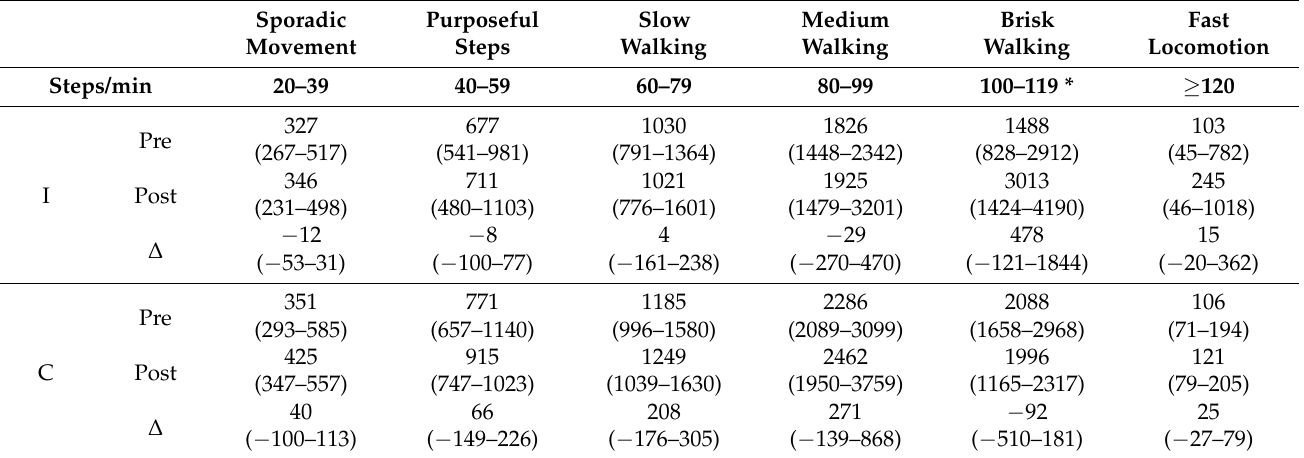
Table 4. Number of steps taken within cadence bands (I = Intervention group; C = Control